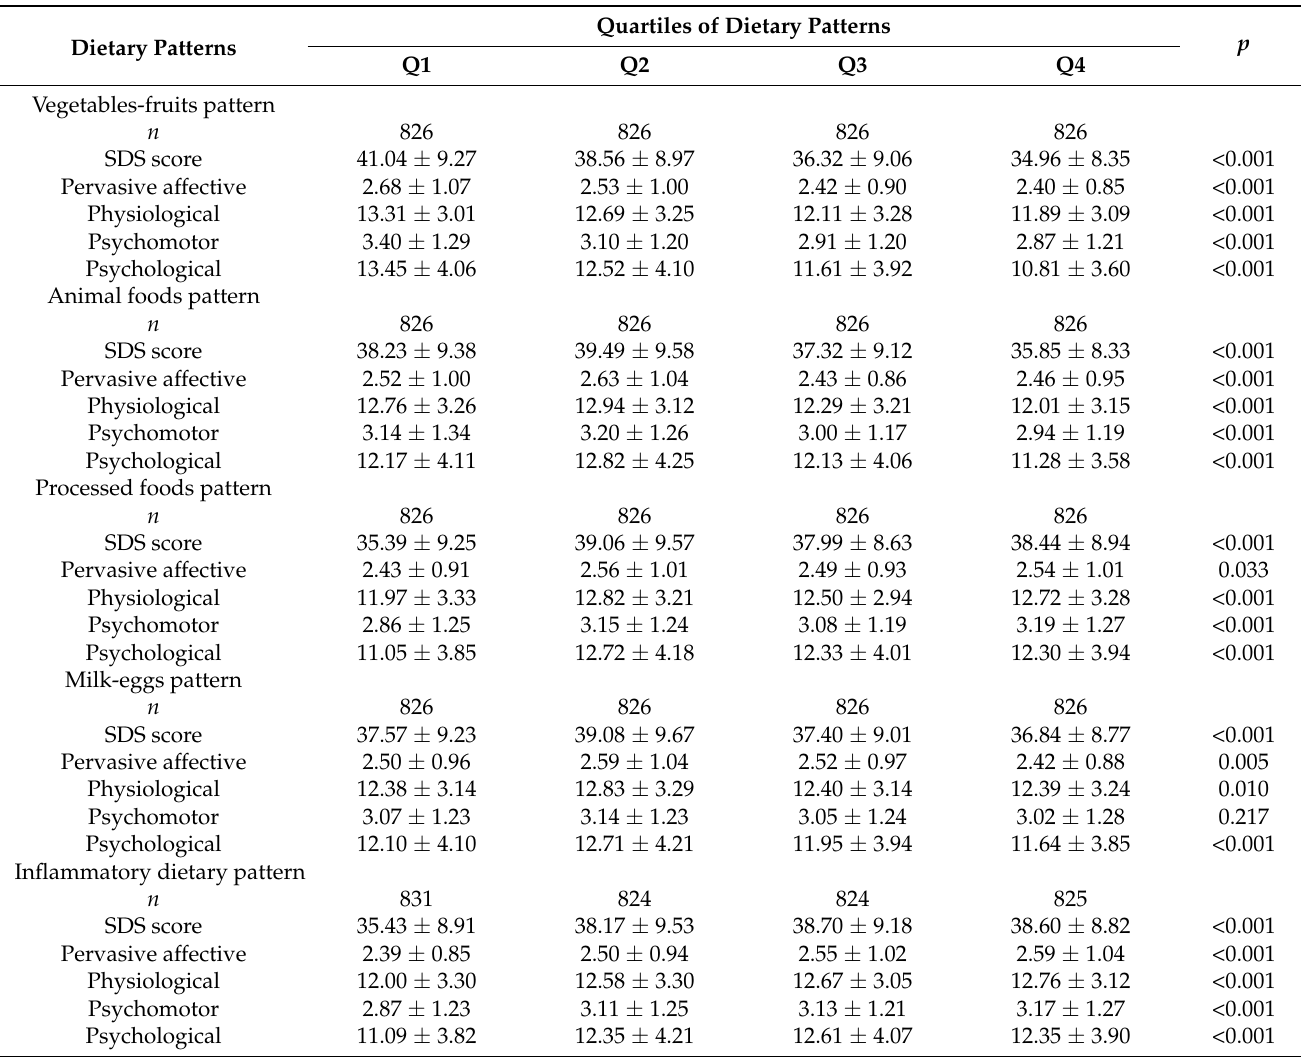
Table 4. Depression self-rating scale score according to categories of dietary patterns ( n = 3304, Mean ± SD